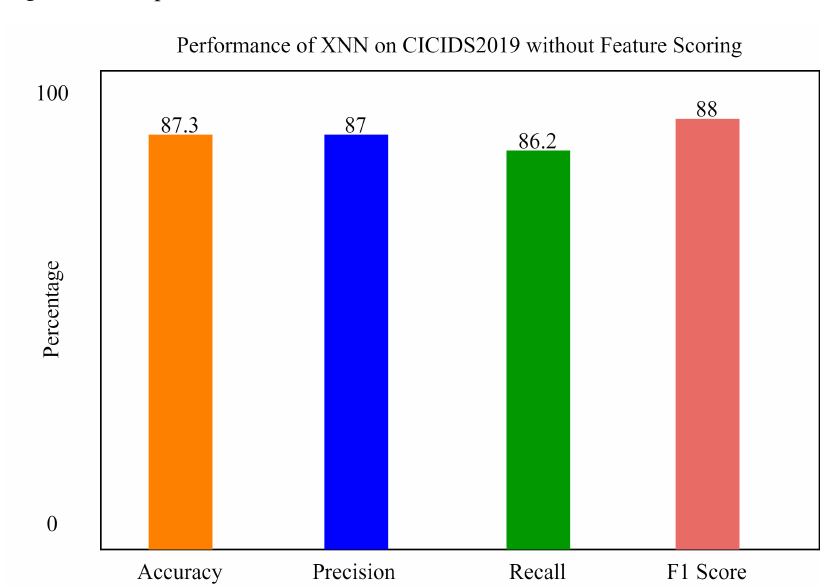
Figure 13. The performance of xNN on CICIDS2019.